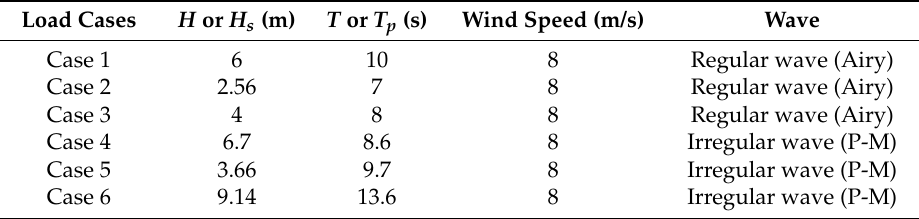
Table 4. Settings of the load cases.